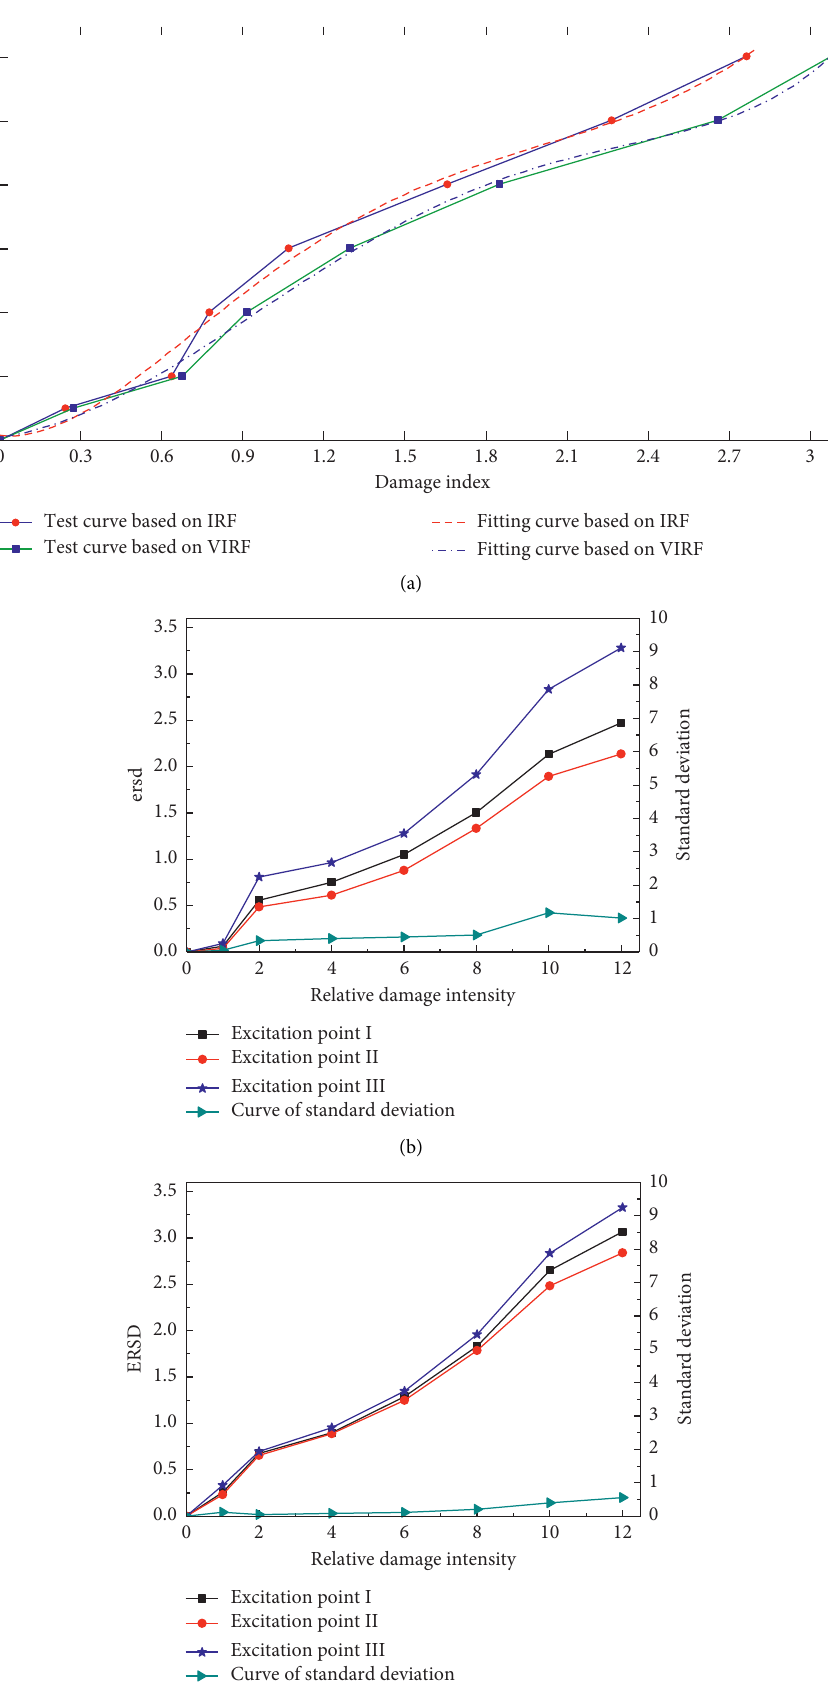
Figure 10: Relationship curve between the damage index and damage intensity. (a) Tests curves and fitting curves. (b) Curves based on IRF. (c) Curves based on